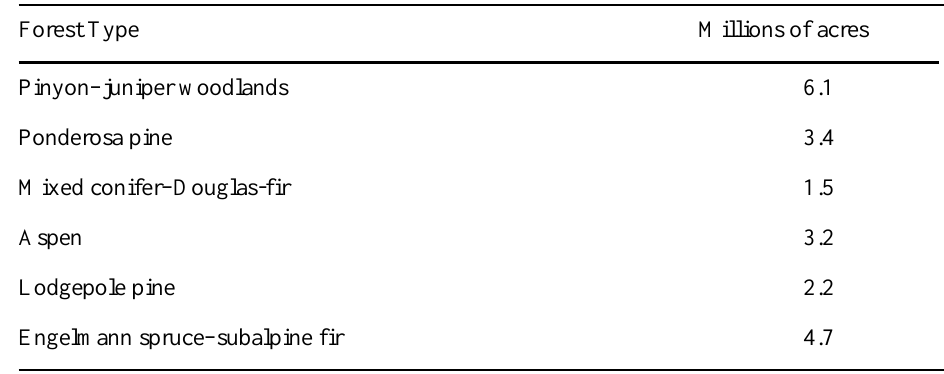
Table 1. Extent of major forest types in Colorado (from Schrupp et al.